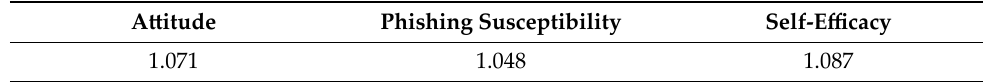
Table 2. Full Collinearity Testing.